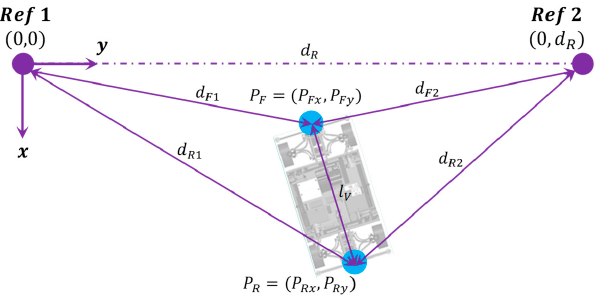
Figure A1. Method to measure the reference position of the vehicle.